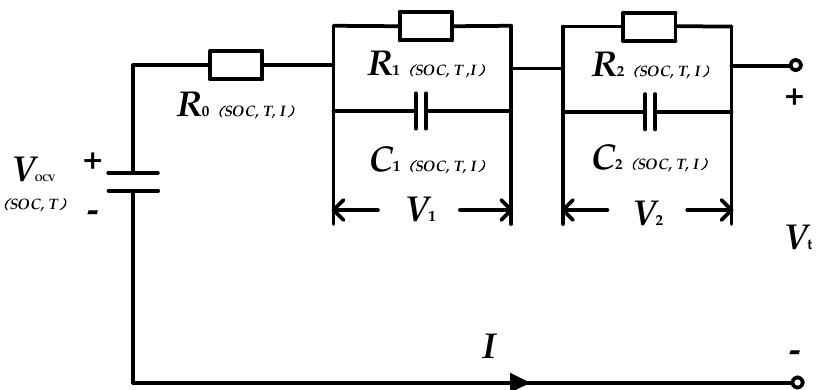
Figure 2. Structure of the proposed temperature-dependent second-order RC equivalent circuit model.